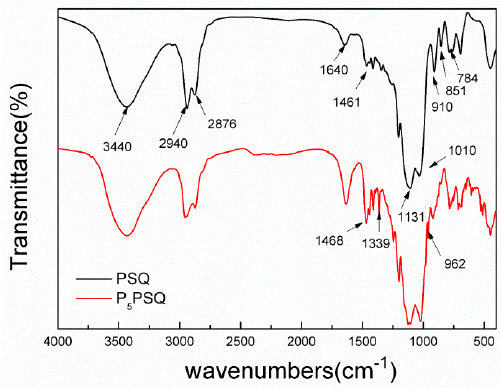
Figure 1. FT-IR spectra of PSQ and P 5 PSQ.